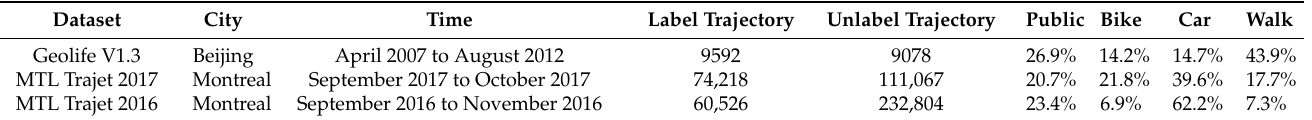
Table 2. GPS data